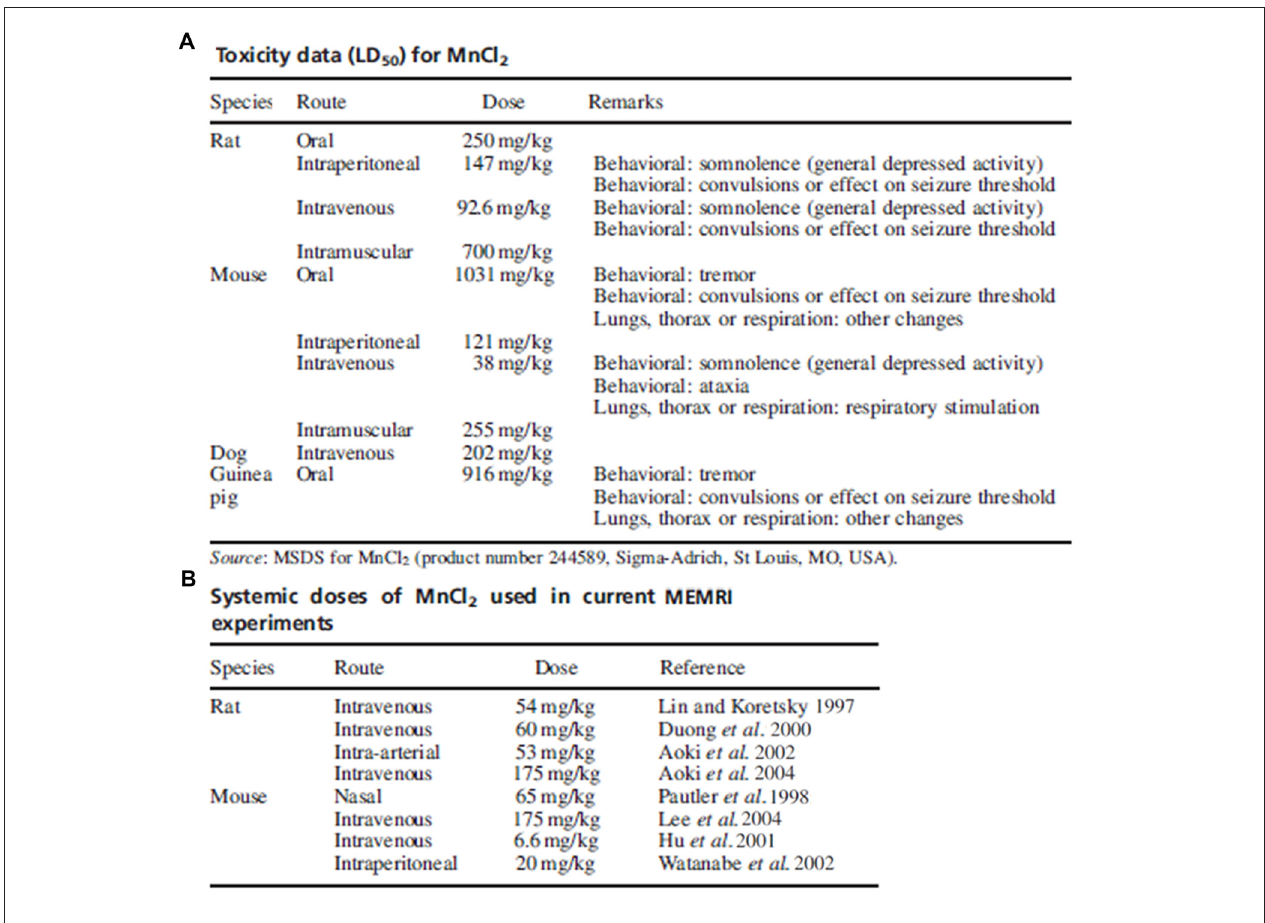
studies in rats and mice. With some exceptions, the dose of manganese used in imaging studies is much lower than the accepted toxic